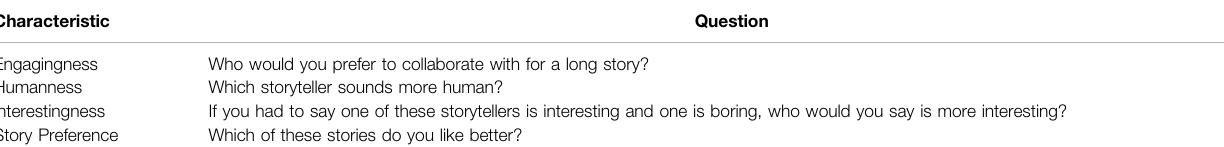
TABLE 9 | Questions asked to human evaluators of collaborative storytelling